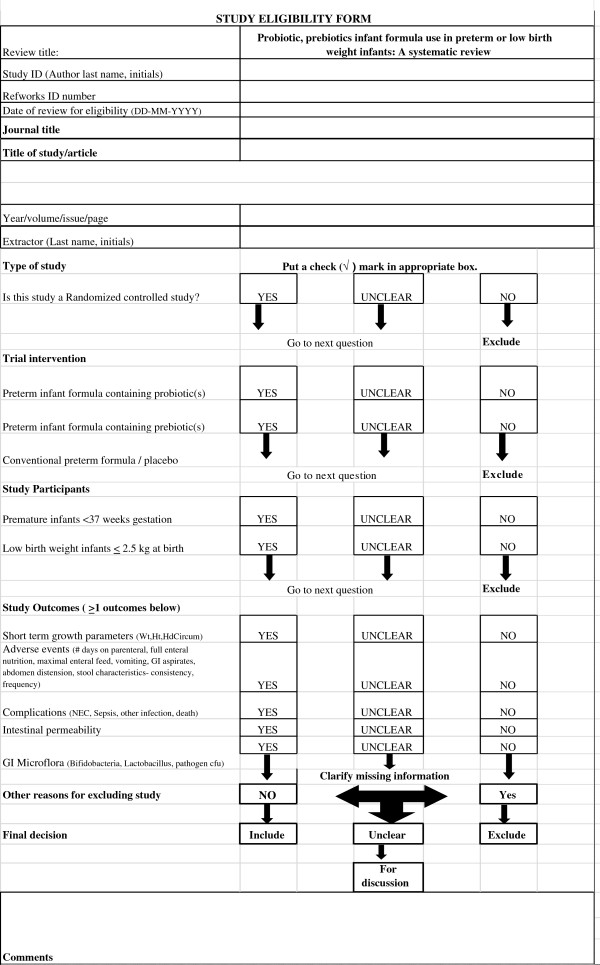
Study eligibility form.